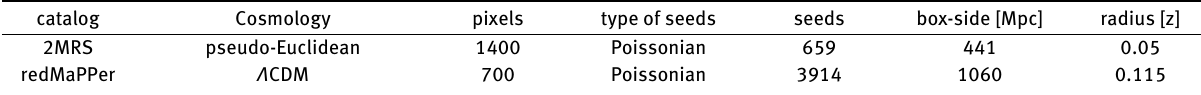
Table 2. Numerical values for the parameters of the Voronoi Diagrams.